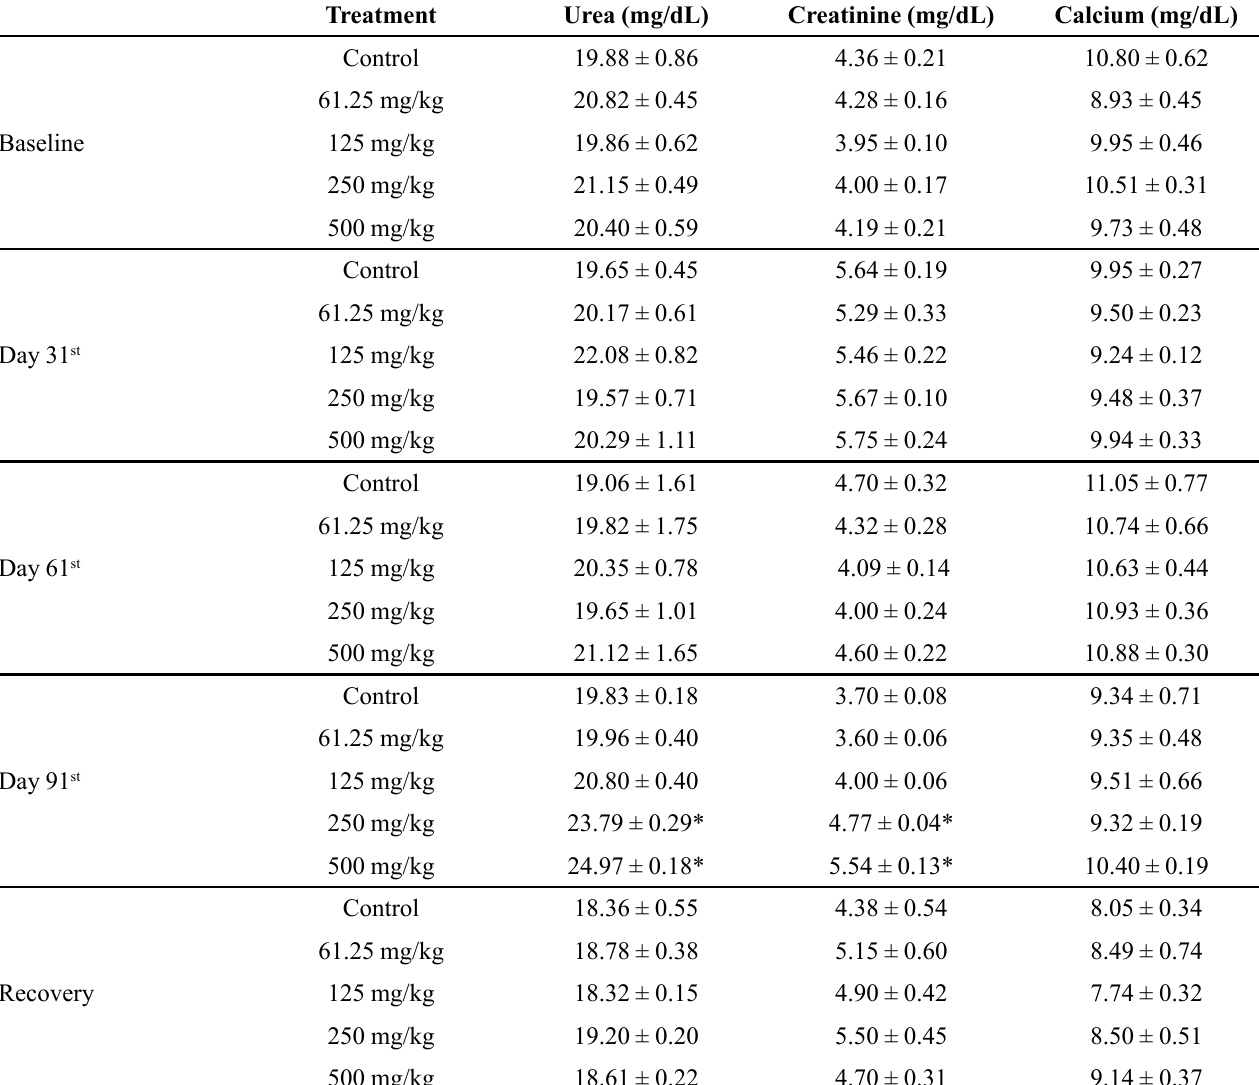
TABLE VIII - Effect of sub-chronic administration of Dryopteris filix-mas ethanol leaf extract on urea, creatinine and calcium of albino